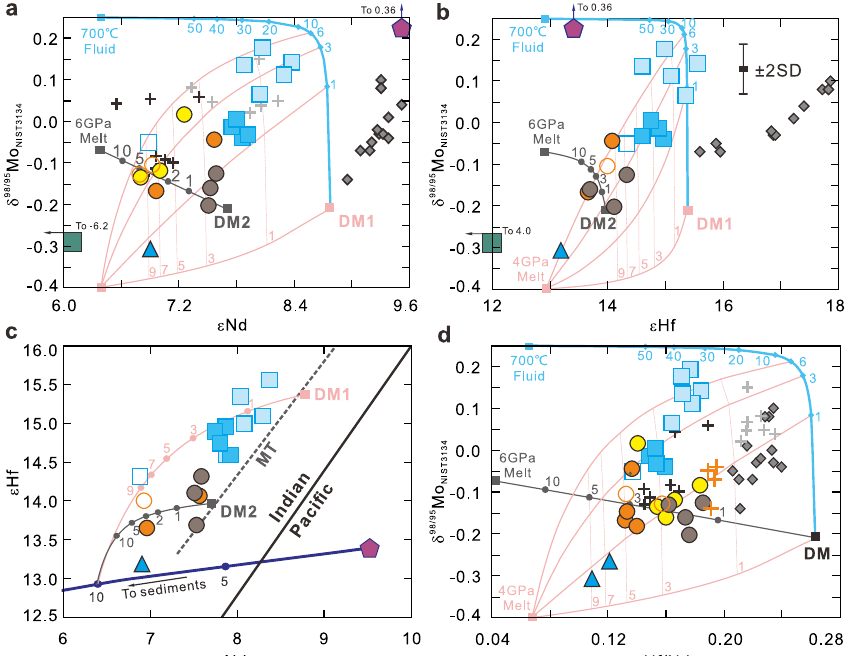
Fig. 5 Mo, Nd, and Hf isotopes and Hf/Nd of Pagan and NW Rota-1 volcanic rocks. Plots of a δ 98/95 Mo vs. ε Nd, b δ 98/95 Mo vs. ε Hf, c ε Hf vs. ε Nd, and d δ 98/95 Mo vs. Hf/Nd for the Pagan and NW Rota-1 samples unaffected by amphibole fractional crystallization, illustrating the slab dehydration/melting process. The Izu, other Mariana volcanic front, average Mariana sediments, and 801 C AMOC Super Composite data are also plotted for comparison. The depleted mantle 1 (DM1), DM2, 700 °C slab fl uid, 4 GPa slab melt, and 6 GPa slab melt compositions are listed in Supplementary Table 1. The numbers on the mixing curves between different compositions represent the mass percentage of the slab fl uid/melt. The solid black line in ( c ) is the boundary of Hf – Nd isotopic composition between the Indian and Paci fi c Ocean mantle domains 50,54 . The Hf – Nd isotopic trend of the Mariana Trough (MT) mantle is according to Woodhead et al. 53 . SD standard deviation. The symbols and data source are as in Fig.